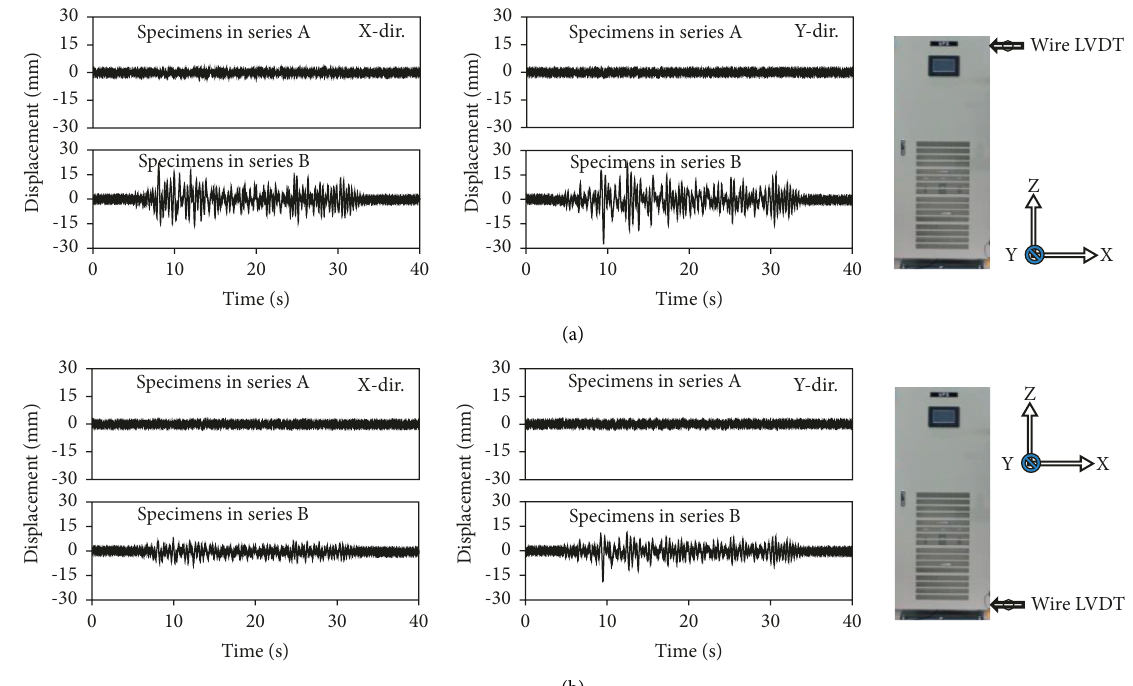
Figure 16: Displacement response time histories of the test specimens in Series A and B of the AC156_100 test. (a) At the top of the UPS. (b) At the bottom of the UPS. Table 6: Peak displacement at tops and bottoms of the UPS test specimens. Relative displacement (mm) Specimens Scaling factor (%) Top Bottom